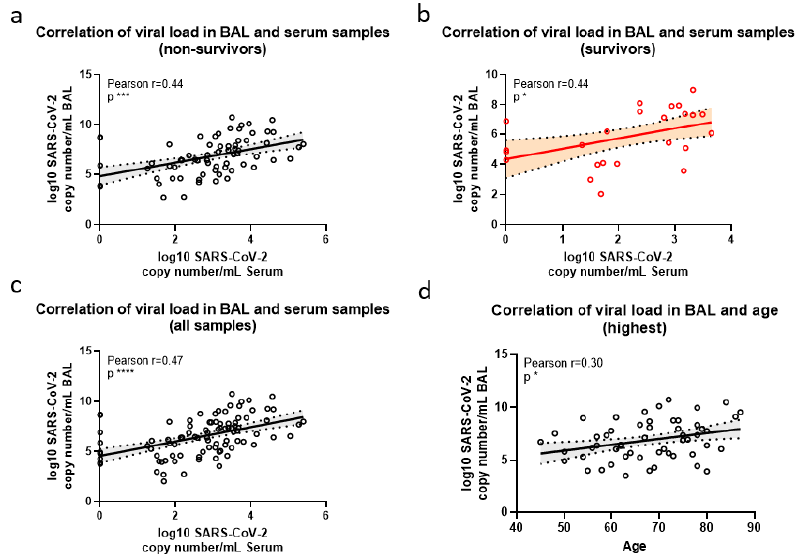
Figure 4. Correlation of SARS-CoV-2 viral load in BAL and serum samples of severe COVID-19 ICU patients. BAL and serum samples were obtained from ICU patients with severe COVID-19 at the same time points. A linear regression and Pearson correlation analysis was performed on the viral load in BAL and serum samples at each time point for deceased ( a ), survivors ( b ) and of all samples ( c ) as well as the viral load in BAL and age with highest samples per patient ( d ). Dotted lines show the 95% confidence interval. * = p < 0.05; *** = p < 0.001; **** = p < 0.0001